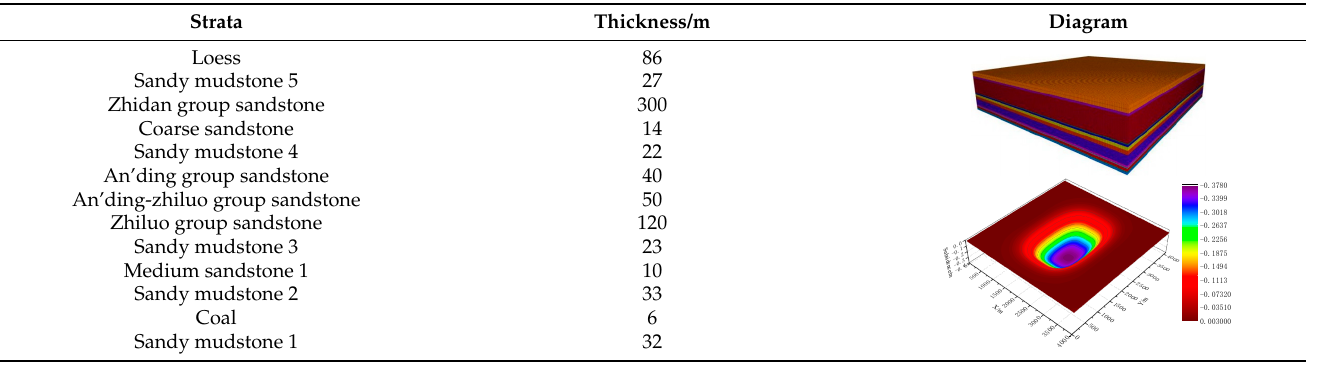
Table 8. Three-dimensional numerical model [49].